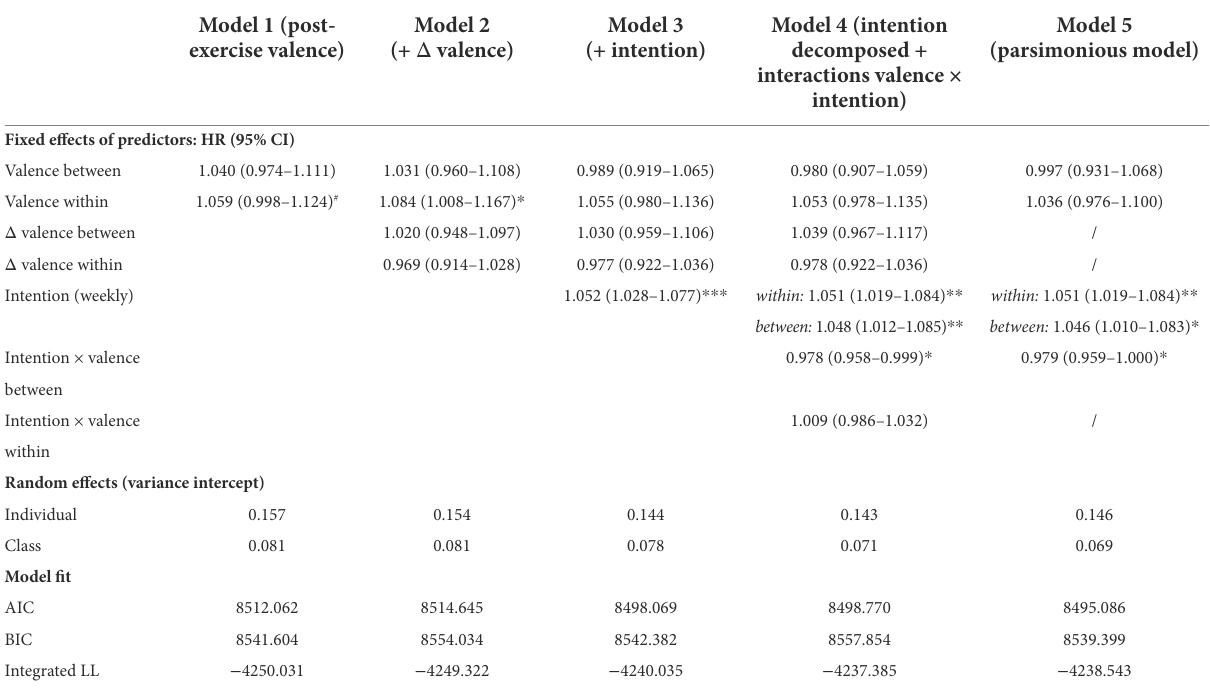
TABLE 3 Results of Cox multilevel survival models for the prediction of re-attendance by affective